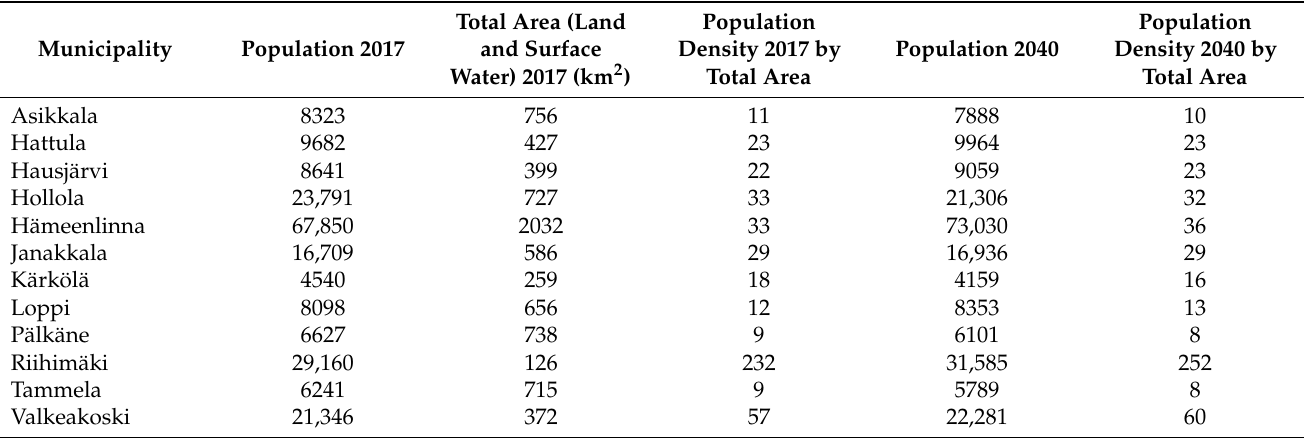
Table 2. Population density projection by municipality for